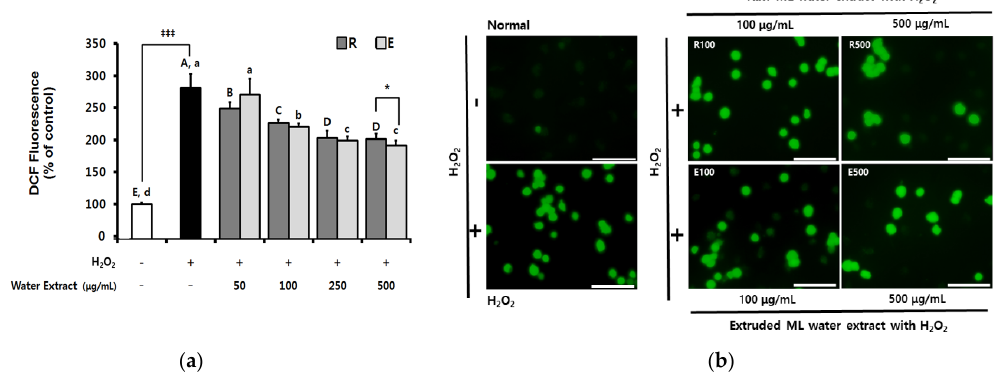
Figure 4. Inhibition of H 2 O 2 -induced reactive oxygen species (ROS) generation by extruded mulberry leaves’ water extract in RAW 264.7 cells. ( a ) The degree of ROS production as measured by dichlorofluorescein fluorescence and ( b ) images obtained by fluorescence microscopy (magnification, 200×; scale bar, 100 μ m). ML, mulberry leaves; R, raw ML water extract; E, extruded ML water extract. Data are expressed as the means ± SD. Different uppercase letters for (R) or lowercase letters for (E) represent significant differences between groups according to ANOVA followed by Duncan’s multiple range test ( p < 0.05). H 2 O 2 -stimulated group without sample treatment compared with unstimulated control group by independent t -test ( ‡‡‡ p < 0.001). R group compared with E group by independent t -test (* p < 0.05).